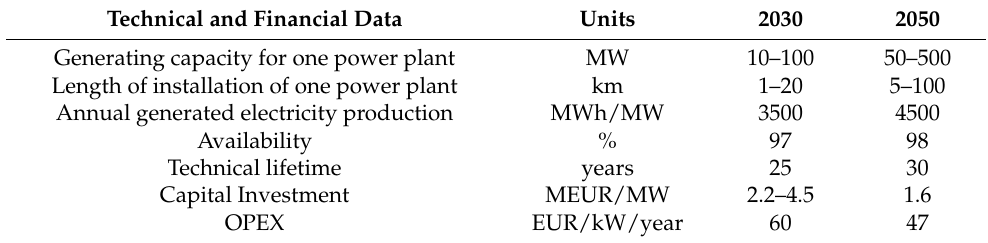
Table 4. Wave power data sheet from the Technology Data Catalogue [15]. Data adapted from